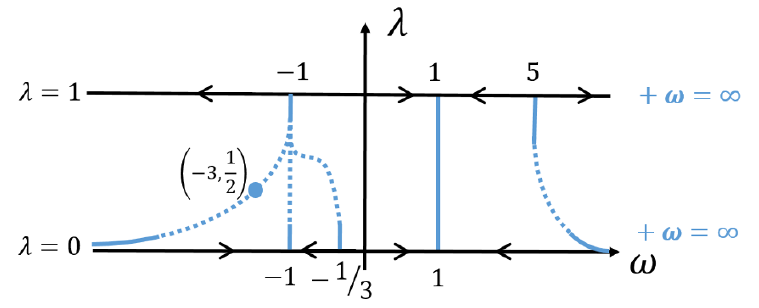
Figure 13. Qualitative RG (cid:13)ows of the N = 1 N f = 1 CS-matter theories at large N . The solid lines (and the point ( (cid:0) 3 ; 1 )) represent exact results that follow from a direct analysis of 2 the (cid:12) function for small (cid:21) . The dashed lines are the conjectured behavior for all (cid:21) . There is an additional (cid:12)xed point at ! = 1 for (cid:21) close to zero and close to one, whose behavior for general (cid:21) cannot be found using our analysis. The results for negative (cid:21) can be obtained by using a